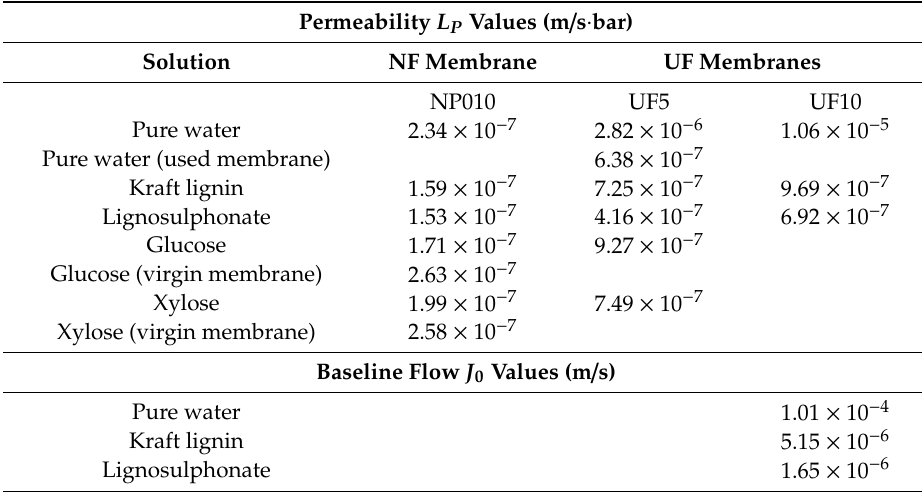
Figure 5. Influence of the operating pressure on the permeate production with the different solutions for ( a ) the NP010 membrane, ( b ) the UF5 membrane, and ( c ) the UF10 membrane. Table 2. Permeability and baseline flow values of the tested membranes with the different solutions.